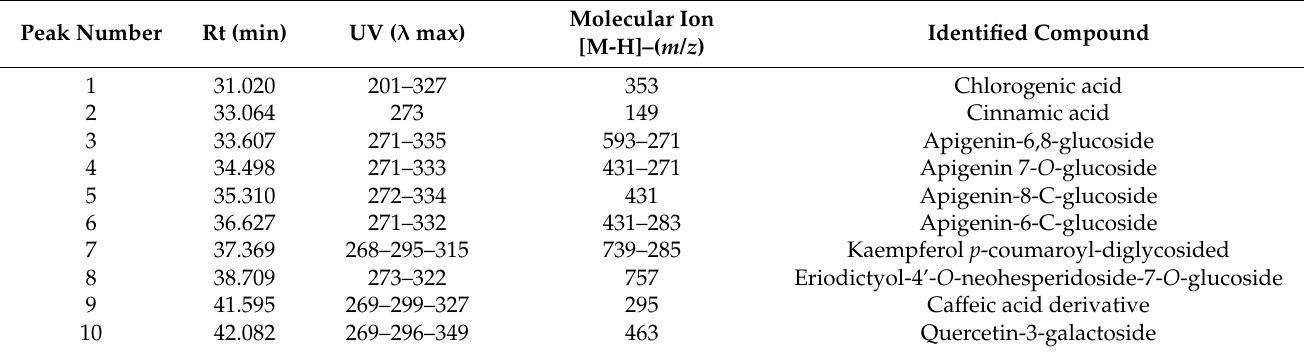
Table 1. Phenolic components detected in the E. spinosissimus root methanolic extract by HPLC-PDA-